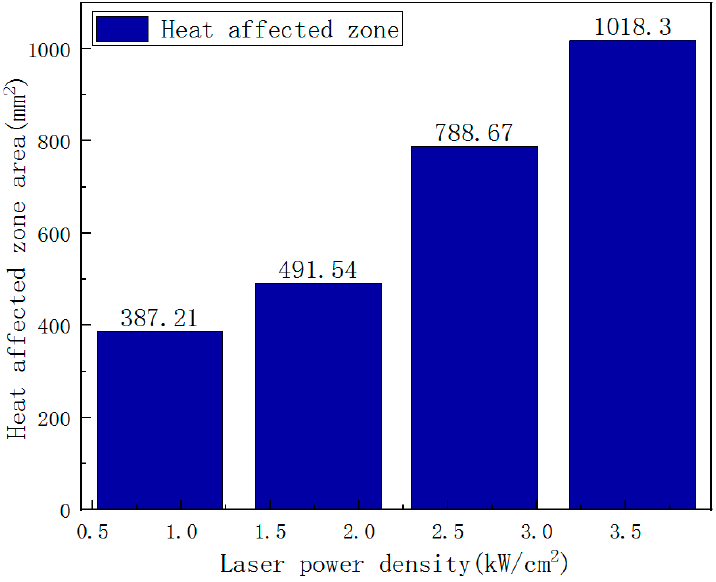
Figure 10. Variation of the HAZ area along the CFRP thickness direction with different laser power.